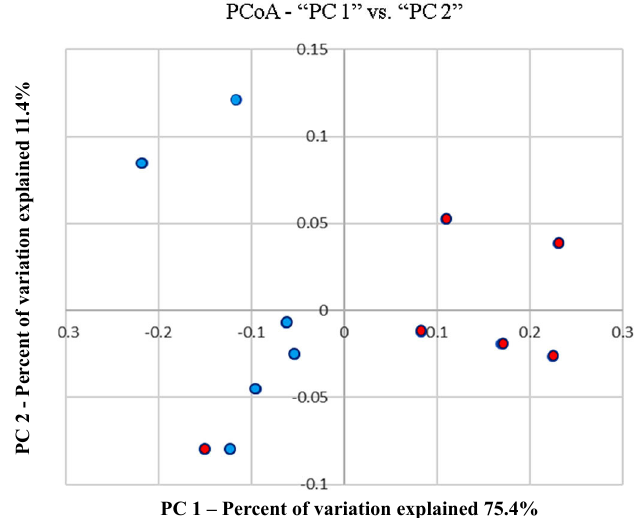
PC 1 – Percent of variation explained Figure 3- Principal coordinate analysis (PCoA) of weighted UniFrac distances of 16S rRNA genes. Data were obtained from HG (blue dots) and LG (red dots) samples (n=6/group)